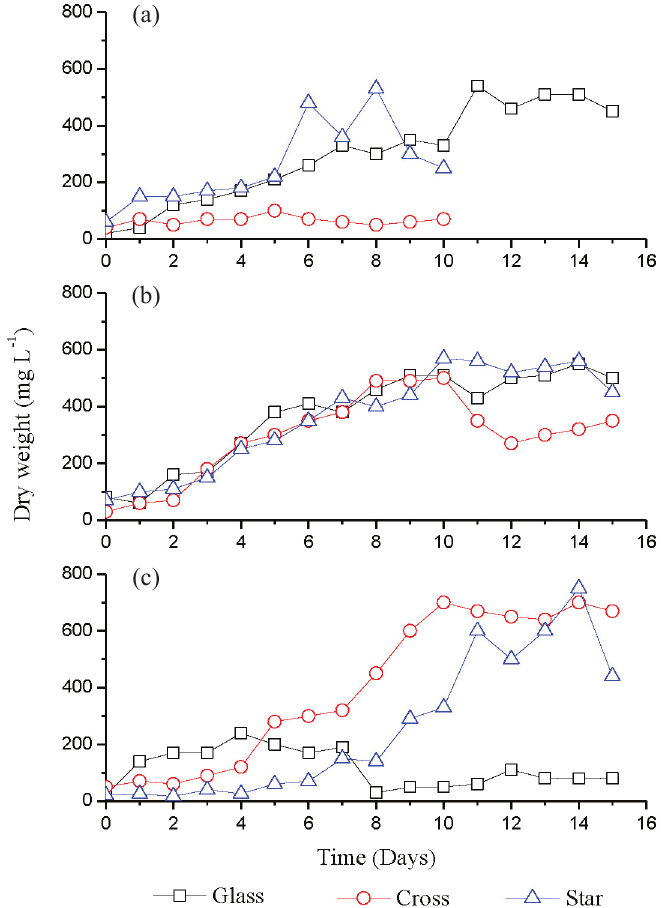
Fig. 3 – Kinetic growth of Chlorella vulgaris in the airlift with an air flow rate of a) 0.6 vvm (9 L min –1 ), b) flowrate of 1.0 vvm (17 L min –1 ), and c) 1.2 vvm (20 L min –1 ), and three different spargers